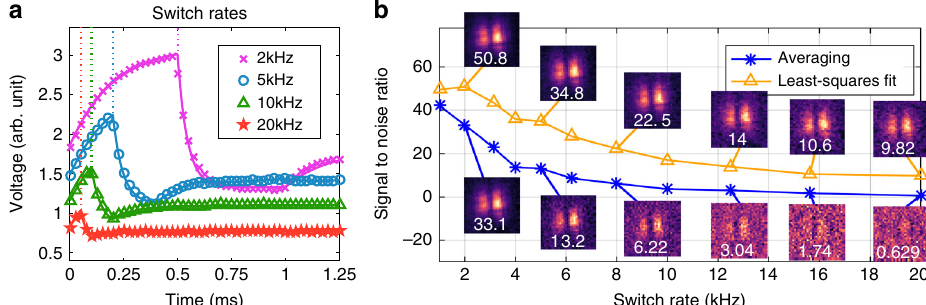
Fig. 3 Signal with switch rate. a The measured voltage against time for different mask switch rates. The markers are the raw data and the solid lines are the fi tted signals. The vertical dotted lines indicate when the fi rst mask was changed for the different switch rates. Note that the data has been vertically offset for visual clarity. b Image signal-to-noise ratio (SNR) against mask switch rate where we have used the proposed least-squares fi tting algorithm (yellow-triangles) and average over the mask duration (blue-asterisks) to estimate the mask values used in image reconstruction. See Supplementary Note 4 for de fi nition and calculation of SNR. Images for 2, 5, 8, 12.5, 15.625 and 20 kHz switch rates are shown with their SNR in white. Note, the signals were acquired by fi xing the delay line at the maximum of the electric fi